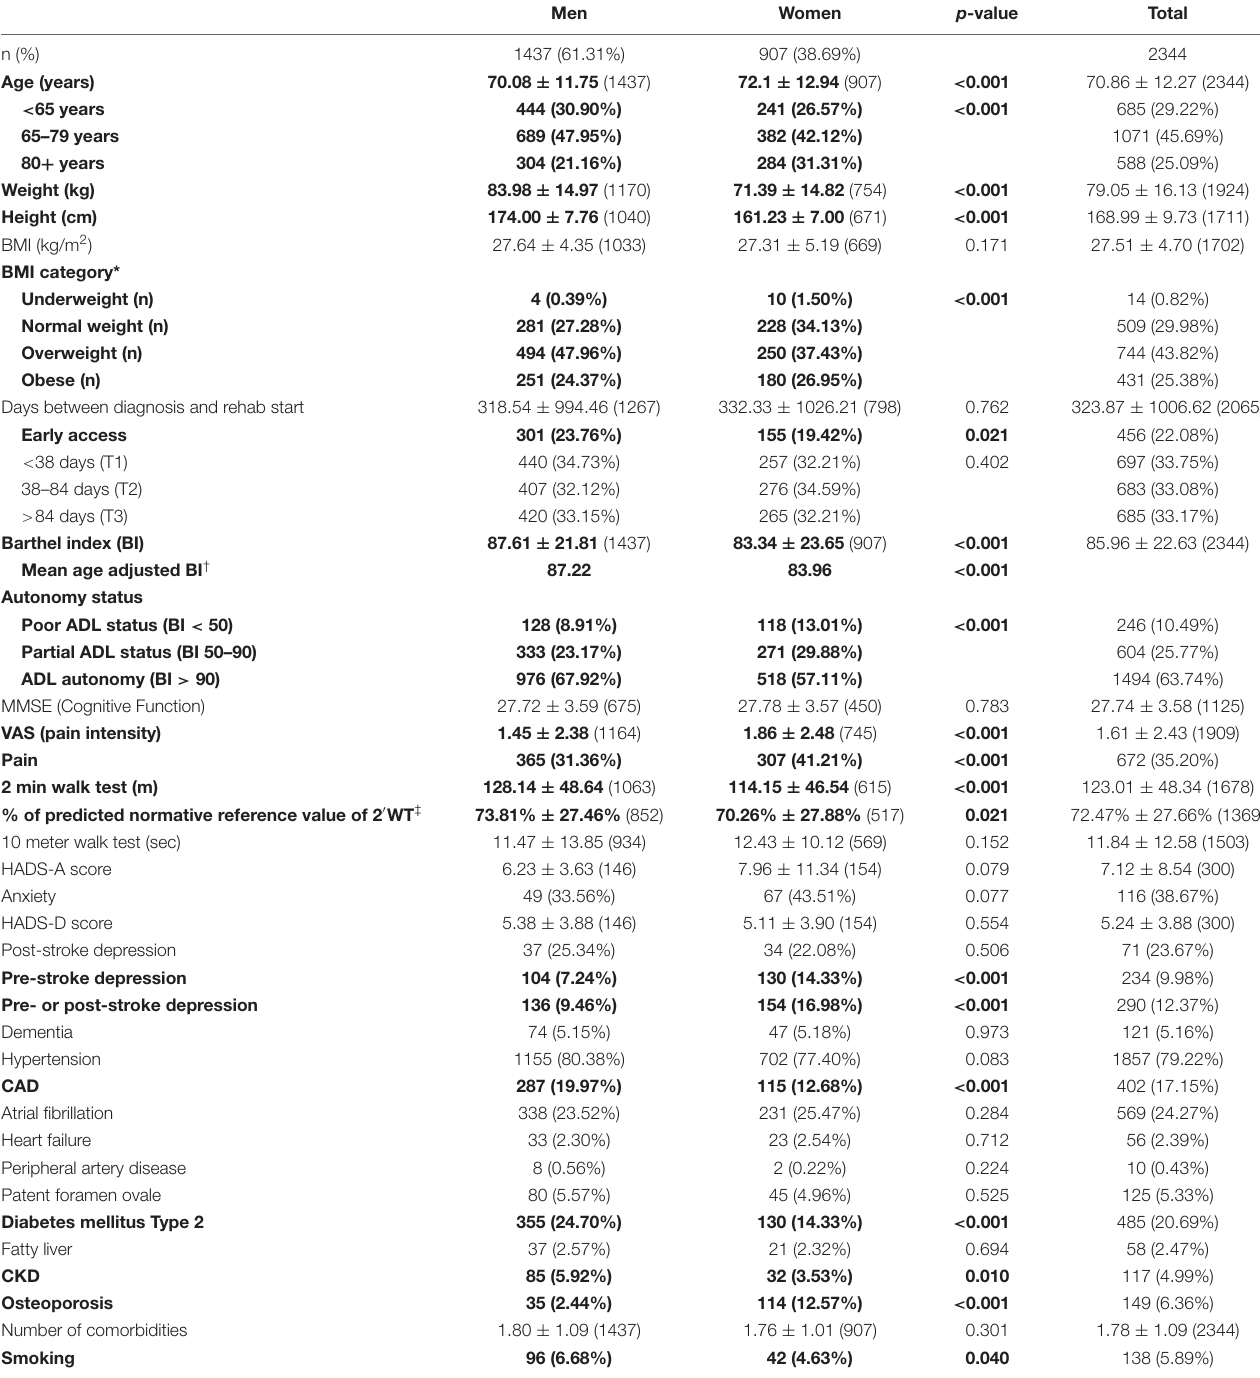
TABLE 1 | Baseline characteristics and comorbidities of men and women with diagnosis of cerebral infarction at admission to neurorehabilitation.